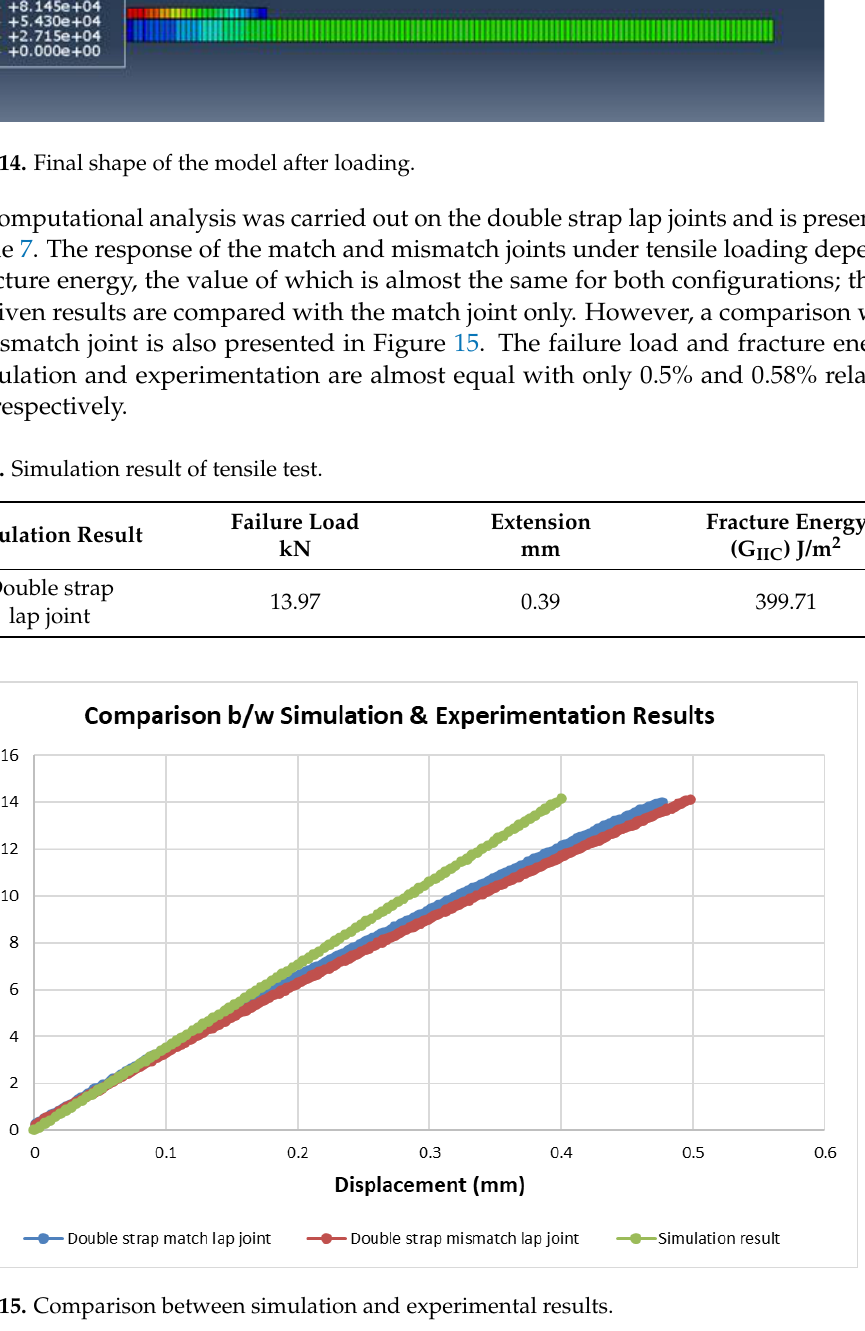
Figure 14. Final shape of the model after loading.